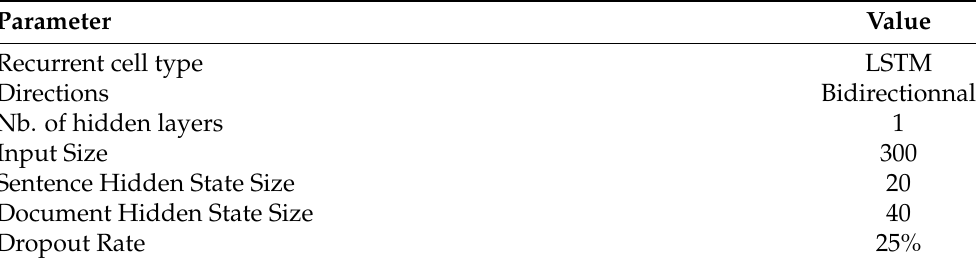
Table 3. HAN Architecture Parameters.